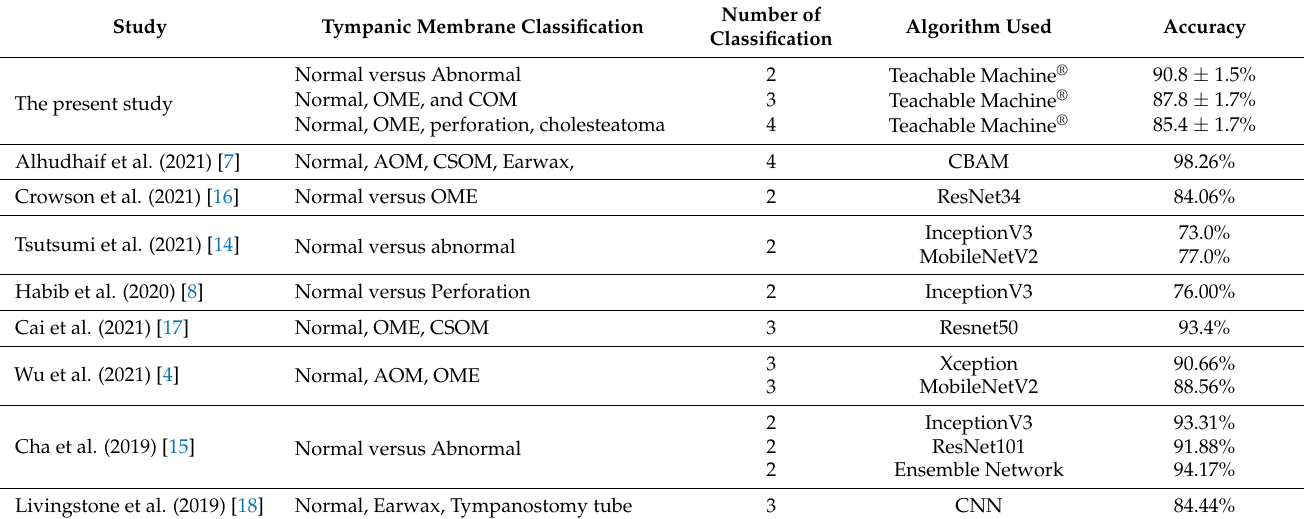
Table 1. Performance of the tympanic membrane classification